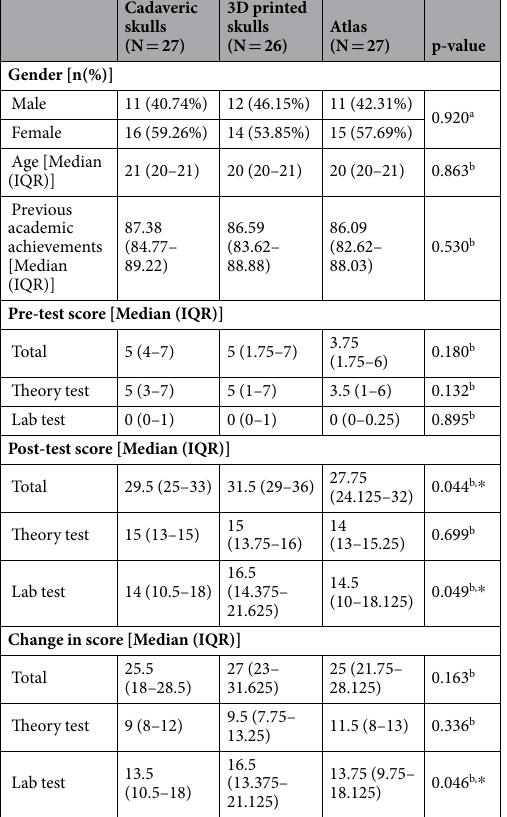
Table 2. Between groups values for age, gender, previous academic achievements and pre- and post-test scores. Full scores of theory test, lab test, and total score were 18, 30, and 48 points, respectively. a Chi-square test. b Kruskal-Walis H. * p <